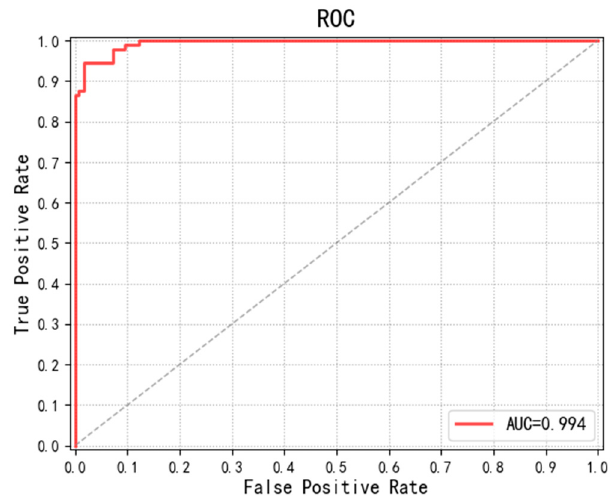
Figure 14. The ROC curve of the proposed model.